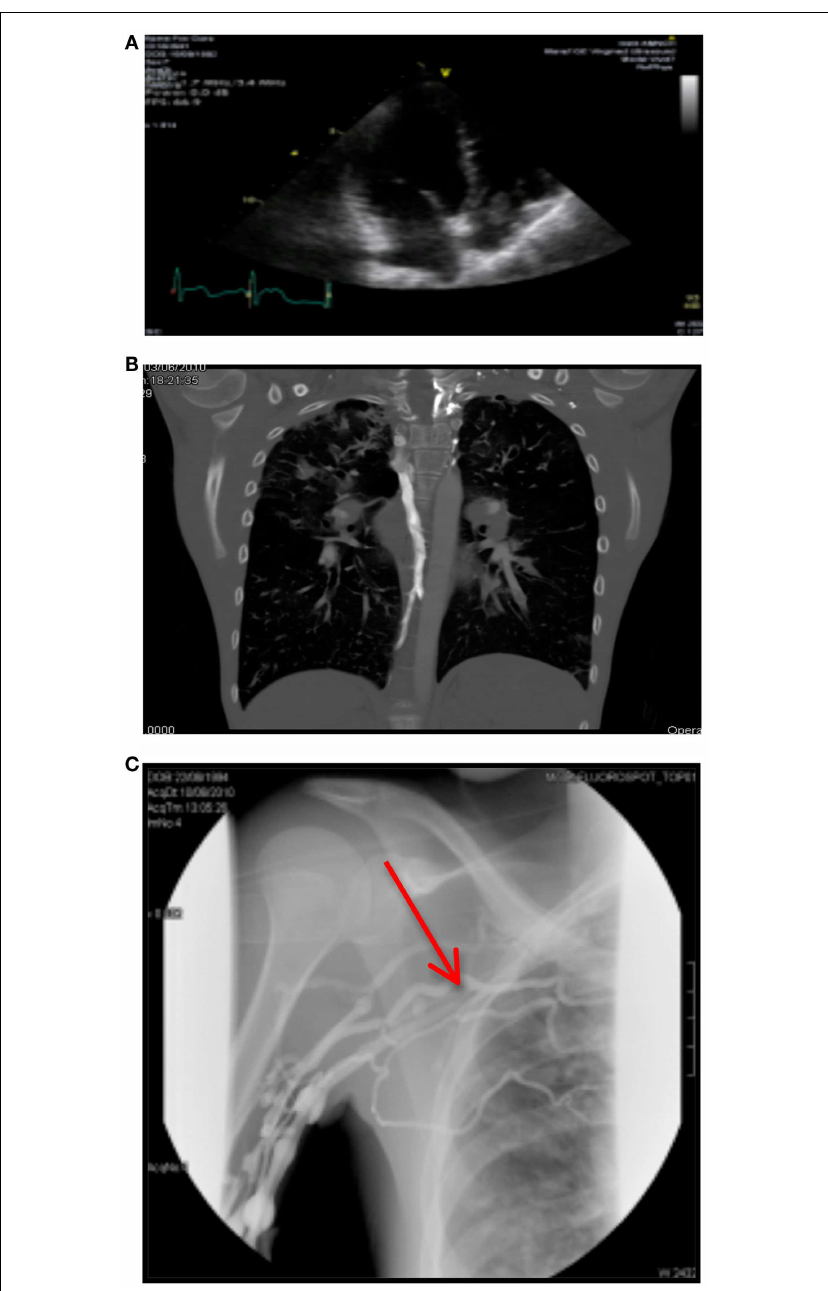
FIGURE 1 | (A) Right atrial thrombus on echocardiography. (B) CTPA showing bilateral arterial filing defects. (C) Venogram showing complete obstruction of right subclavian